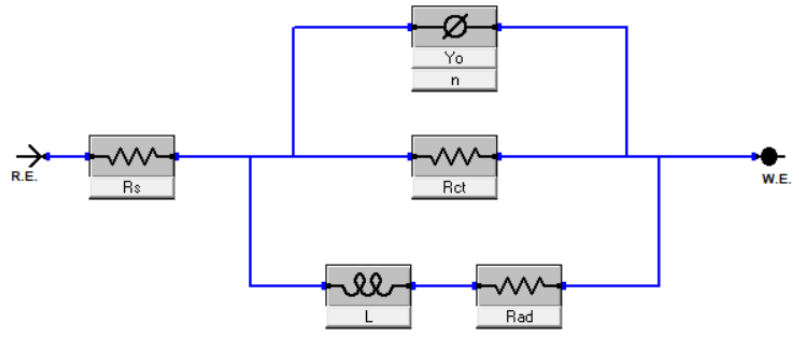
Figure 9. EEC model used for uncoated and EPD-GO-coated Mg samples. Table 3. Different composite coatings and results from the current study and already conducted research.